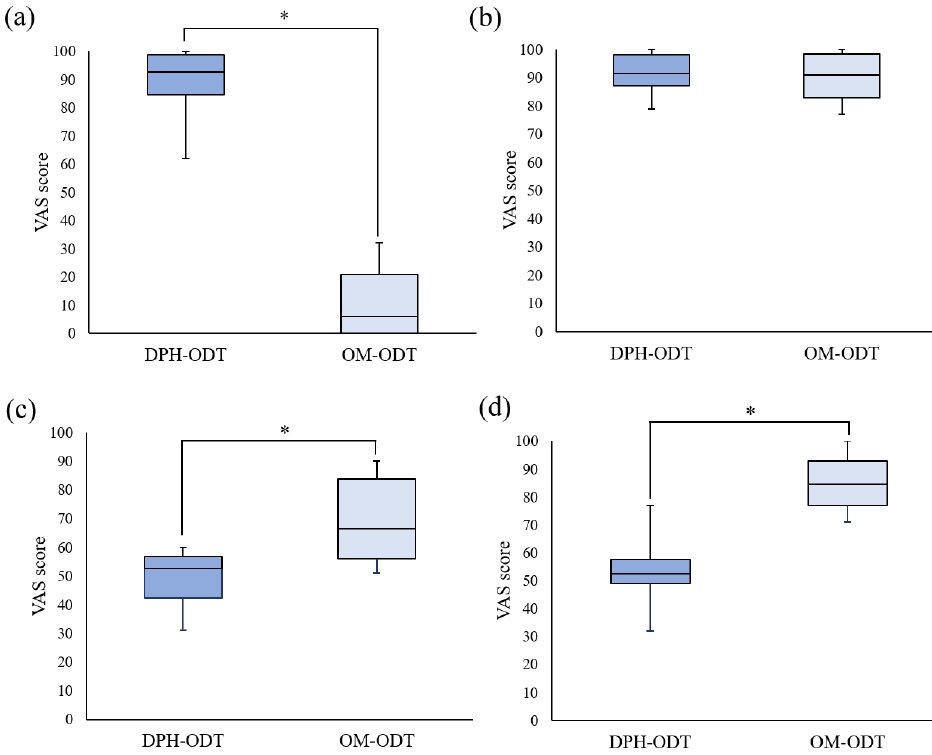
Figure 8. The box-whisker plot of VAS score of ( a ) bitterness score, ( b ) tablet handling, ( c ) grittiness, and ( d ) overall palatability. Note: The statistically significant difference ( p < 0.05) between DPH-ODTs and OM-ODTs is noted by an asterisk.